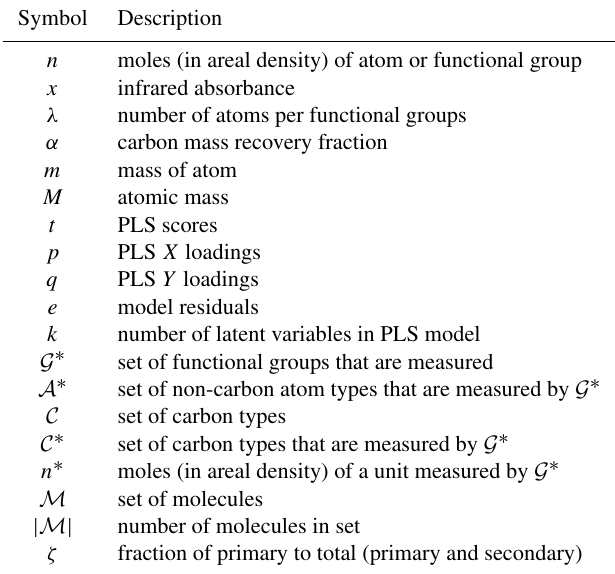
for Bayesian modeling. Table A1. Notation for carbon estimation model.